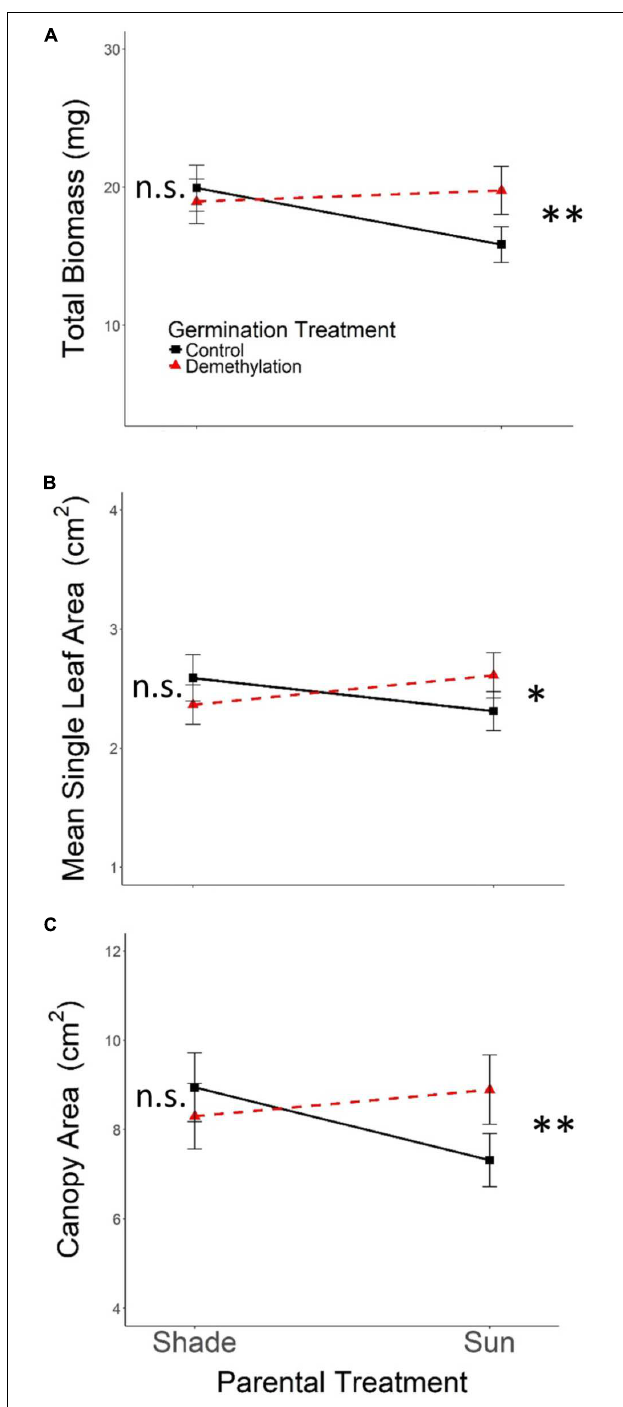
FIGURE 4 | Means ± SE shown ( N = 152) for (A) total biomass, (B) mean single leaf area, and (C) canopy area for offspring of Parental Shade and Parental Sun plants that were exposed to either 0 µ M (Control, solid black lines) or 45 µ M zebularine (Demethylation, dashed red lines) during germination. Results of significant tests for the effect of Control versus Demethylation in each parental treatment group are shown, based on separate within-treatment ANOVAs ( ∗ p < 0.05, ∗∗ p < 0.01, n.s. p > 0.1, see section “Materials and Methods” for